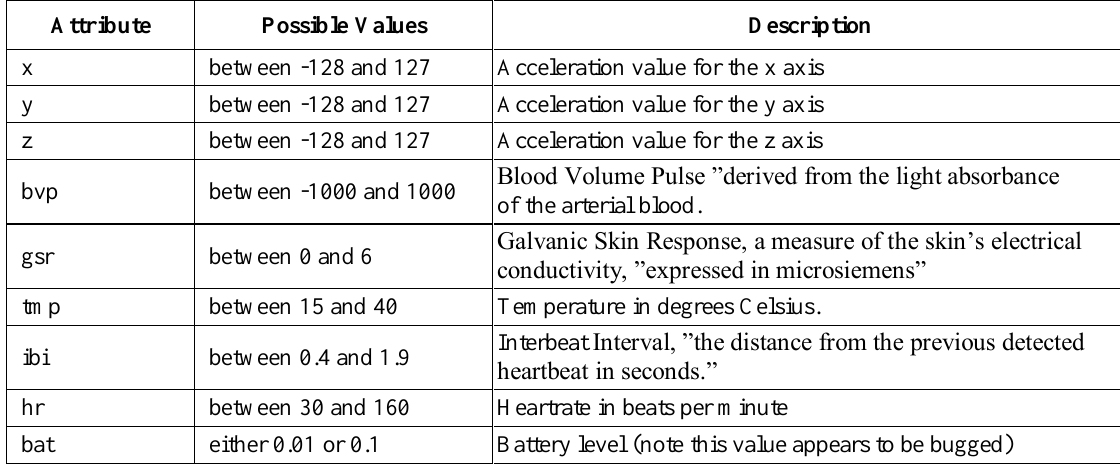
Table 3. Input data from the wristband